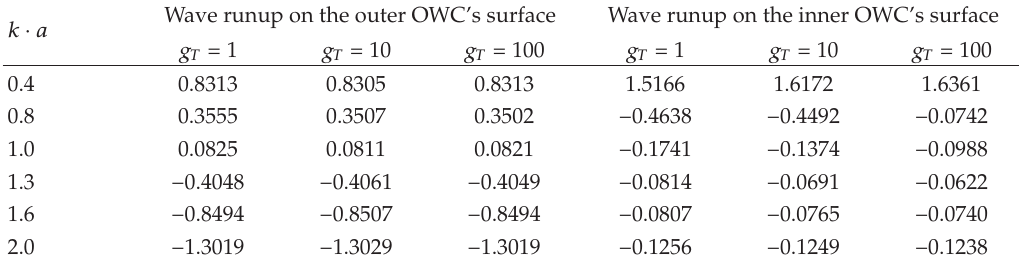
Table 4: Wave runup inside and outside an OWC device versus ka . Angle of wave attack ϑ (cid:8) 0. Wave runup on the outer OWC’s k · a